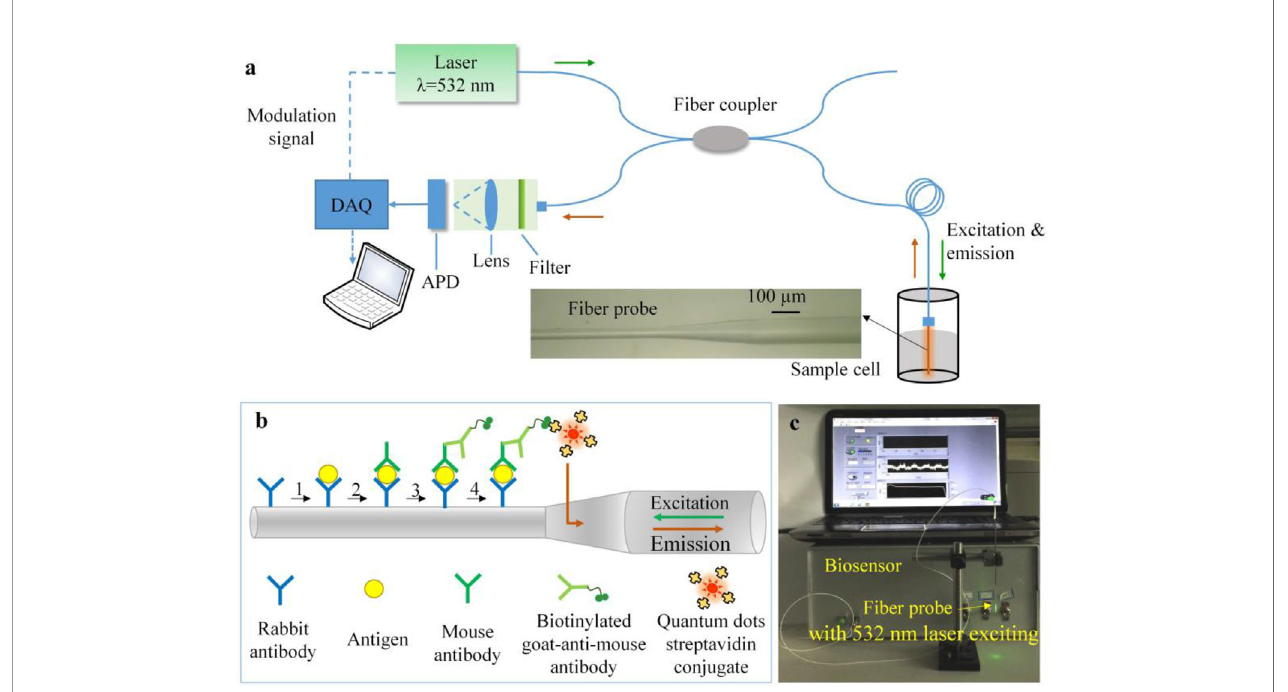
FIGURE 1 | Principle of the fi ber optic biosensor. (A) Schematic diagram of the fi ber optic biosensor. A 532 nm laser was employed as excitation light that transmitted into the fi ber probe through the fi ber coupler. The fl uorescence signal was collected and propagated back through the fi ber coupler, fi lter, lens, avalanche photo-diode (APD), data acquisition (DAQ) system, and at last displayed on the computer. (B) The principle to identify S. aureus using the fi ber probe. The rabbit polyclonal anti- S. aureus antibody immobilized on the probe surface was used to capture as many S. aureus as possible in order to improve the sensitivity. When the S. aureus strains were captured, the mouse monoclonal anti- S. aureus antibody speci fi cally binds to the captured S. aureus again to form a double- antibody sandwich structure. The choice on the two antibodies could ensure that the probe has both high sensitivity and high speci fi city in capturing and detecting S. aureus . The biotin labeled goat-anti-mouse IgG antibody was bound to detecting antibody, and then avidin-labeled quantum dots (QDs) bound with the biotin and emitted fl uorescence signal with the 532 nm laser excitation, the emitted fl uorescence signal was collected at 605 nm wavelength. Moreover, the signal cascade ampli fi cation of the biotin – avidin – QDs system was used to enhance the fl uorescence signal and improve the sensitivity. (C) Prototype of the fi ber optic biosensor. All the components were encapsulated in the box except the fi ber probe and sample cell. The fi ber probe was fi xed by a fl uorescence connector to the fi ber coupler by the fi ber adapter in the front-panel of the